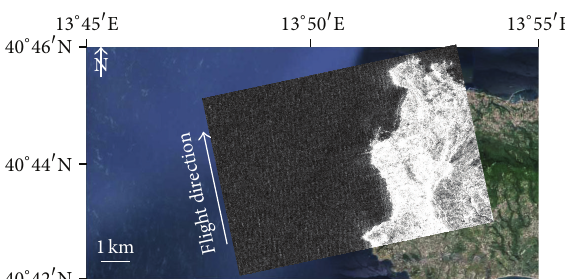
Figure 2: Subset of the ALOS PALSAR stripmap image, 6.25 m × 6.25 m pixel spacing, acquired on February 13, 2007, at 20:28 UTC, covering the west coast of the Ischia Island in the Gulf of Naples, Italy (background image © Google Earth); swell waves propagate along the ground-range direction and phenomena of shoaling and refraction are well visible approaching the